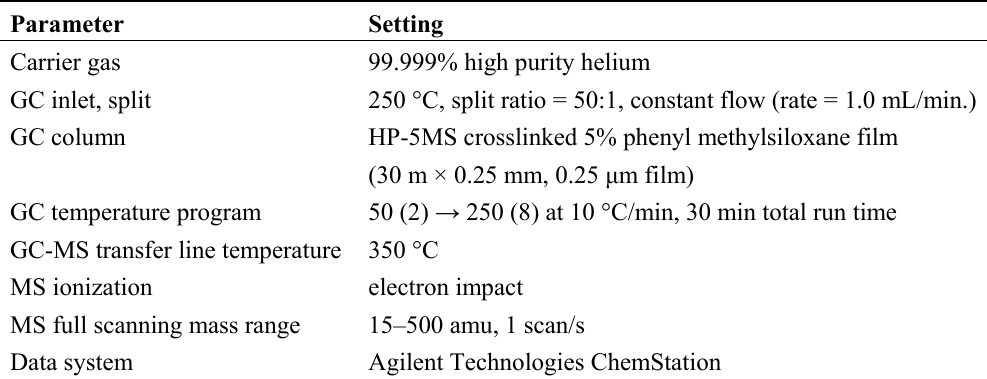
Table 5. GC-MS Experimental